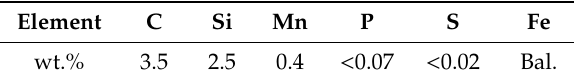
Table 2. Chemical composition of RuT300.